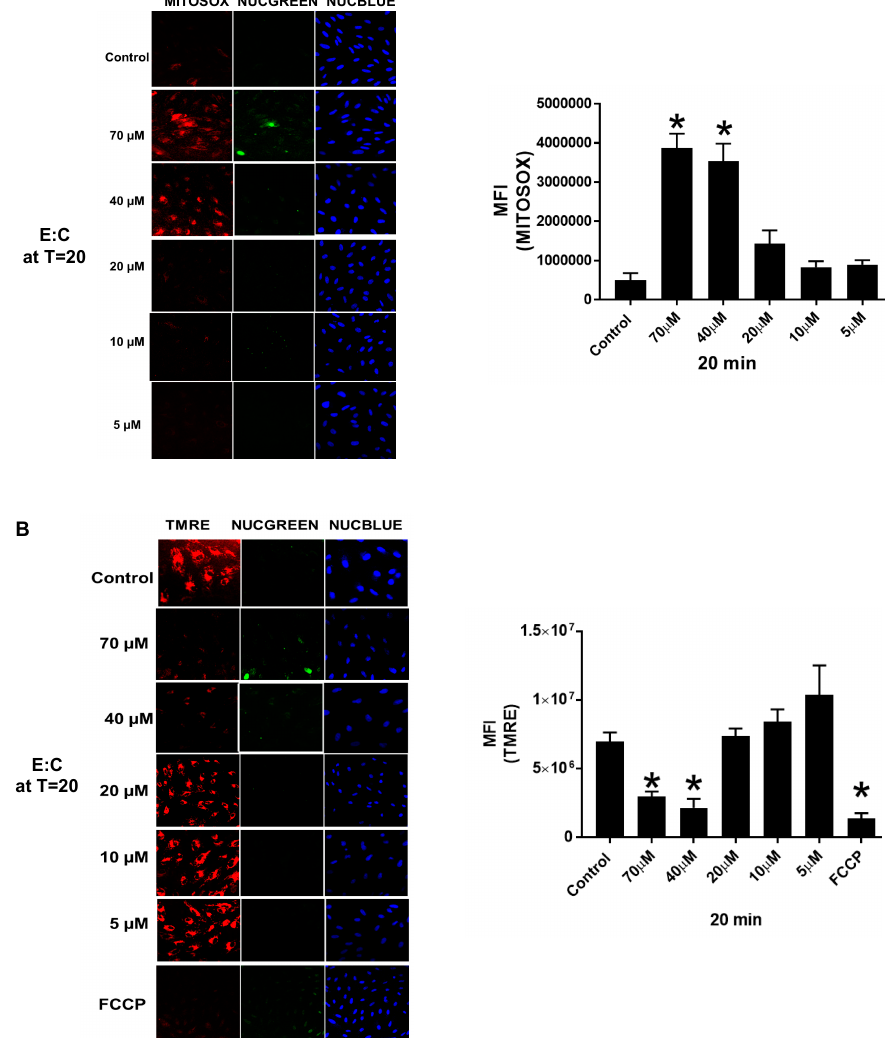
Figure 4. The relationship between E:C-induced superoxide production, membrane potential e ff ects, and cell viability. ( A ) Confocal images and fluorescence intensity measurements in CV-1 Cells treated for 20 min with various concentrations of E:C after staining with the mitochondria-specific superoxide indicator MitoSOX, the cell viability stain NucGreen Dead, and the nuclear stain NucBlue Live. ( B ) Confocal images and fluorescence intensity measurements in CV-1 Cells treated for 20 min with various concentrations of E:C after staining with the mitochondrial membrane potential probe TMRE, the cell viability stain NucGreen Dead, and the nuclear stain NucBlue Live. The proton ionophore and mitochondrial uncoupler, FCCP, was included as a positive control. A minimum of 3 cells / field and 3 fields / slide were imaged for each plate at 20 × magnification using a Zeiss confocal microscope. The images were analyzed using Image J software and the change in mean fluorescence among groups was plotted. Normality of distribution of the data was determined using the D-Agostino Omnibus test. A one-way ANOVA analysis was performed followed by a Dunn’s post hoc test using GraphPad Prism software to identify statistical di ff erence among the samples. N = 3 for each condition; N represents one glass bottomed 35 mm petri dish. * p < 0.05 vs control or